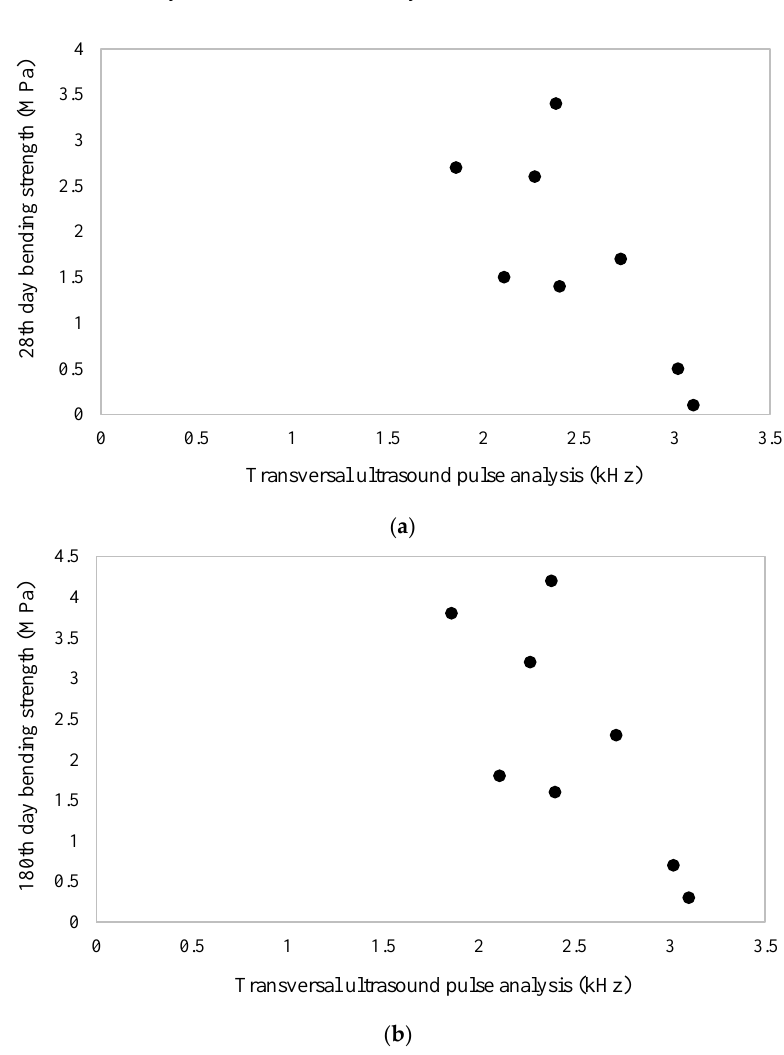
Figure 9. Strong regression relationship for the estimation of bending strength from the transversal UPA on ( a ) the 28th day and ( b ) the 180th day.